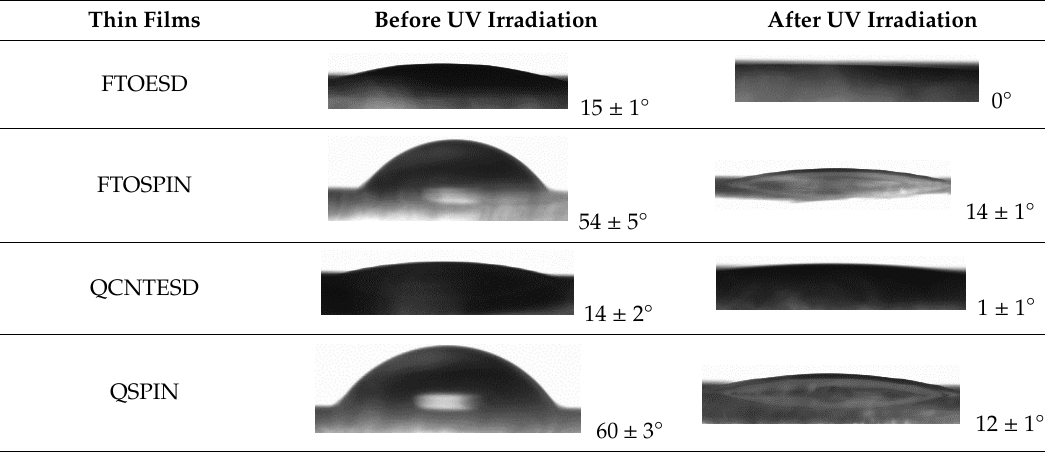
Table 5. Water contact angle of 1.0 µL water droplet on the surface of the heat-treated thin films on two different glass substrates prepared via the ESD and spin-coating processes, FTOESD, FTOSPIN, QCNTESD, and QSPIN, before and after UV-light irradiation with an intensity of 4.5 mW cm −2 at 365 nm for 1 h. Those before UV irradiation were measured after the samples were kept under dark conditions for 1 h.